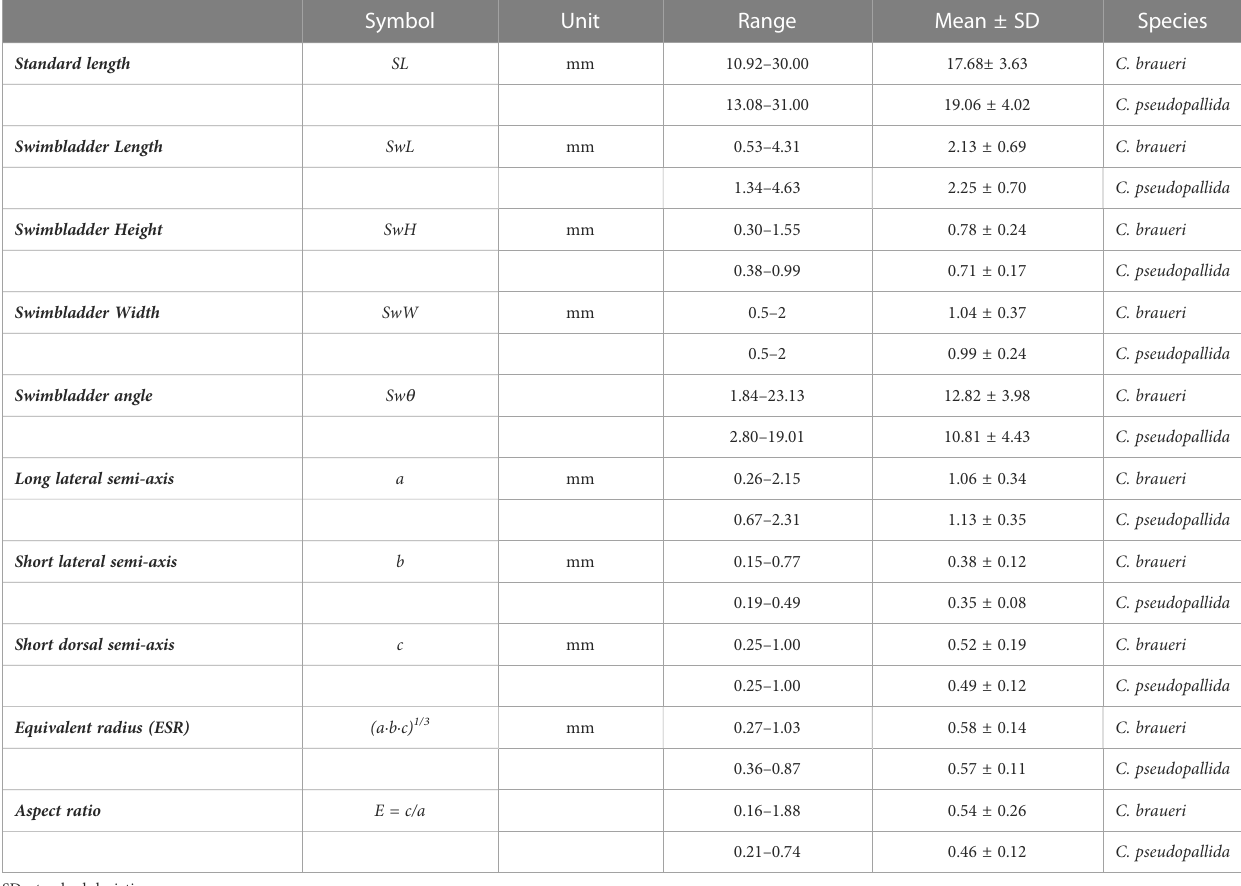
TABLE 5 Measurements of the swimbladder of semi-transparent Cyclothone spp. examined in this study.